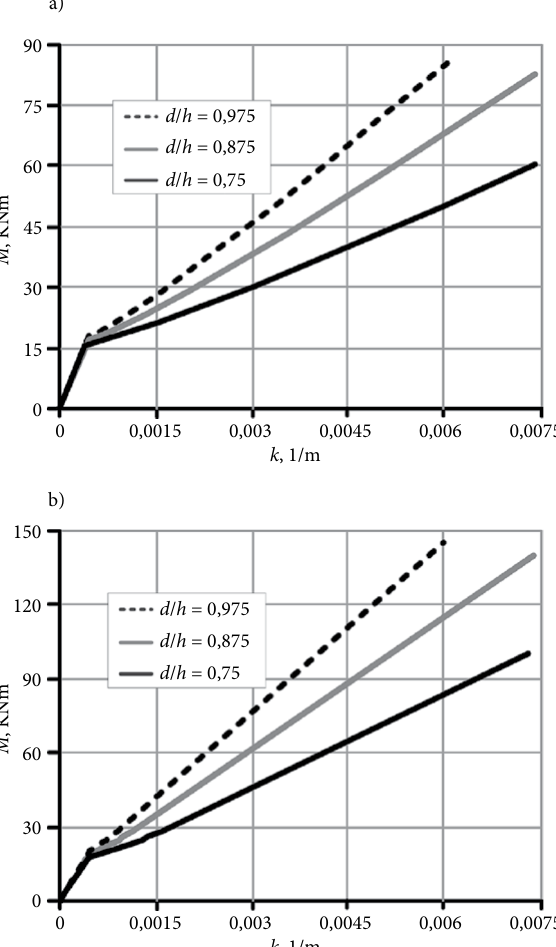
Fig. 3. Moment-curvature diagrams of ranging normalised effective depth: a - r = 1,0 %; b - r = 2,0 %